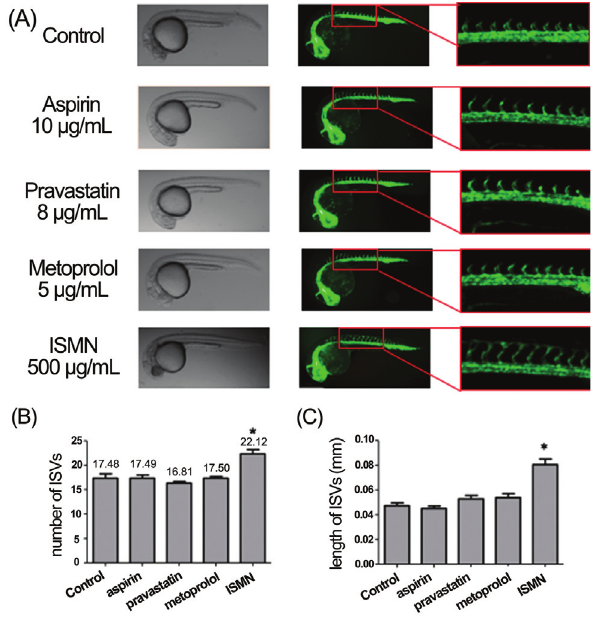
Figure 1 - Screening results of cardiovascular drugs with angiogenic abil- ity using Tg(flk:EGFP) zebrafish. (A) Fluorescence images of 24 hpf zebrafish embryos treated with cardiovascular drugs for 24 h. (B) The number of ISVs in zebrafish embryos. (C) The length of ISVs in zebrafish embryos. Data were expressed as mean (cid:5) SD (n = 3). * p < 0.05.